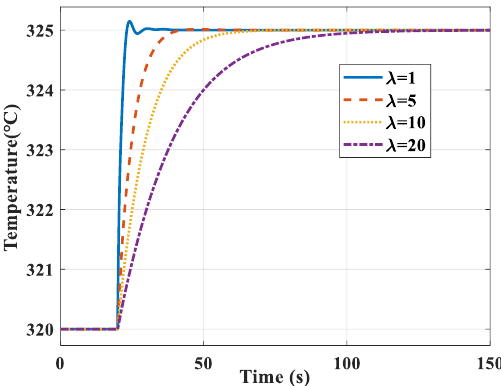
Figure 6. Control performance of IMC with different parameters.